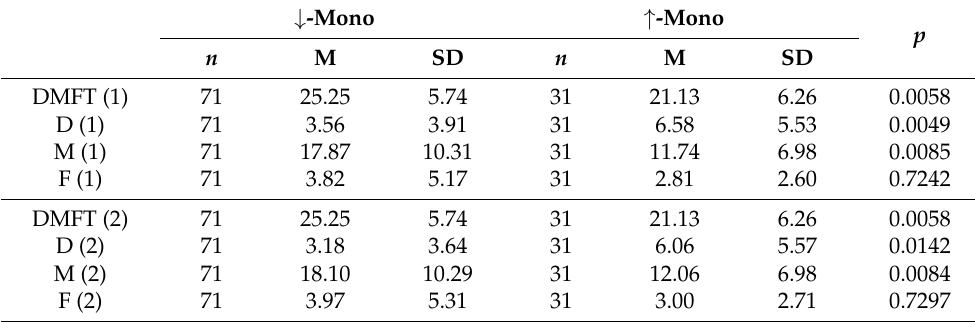
Table 6. Monocytes count change and DMFT index before (1) and after (2) chemotherapy.